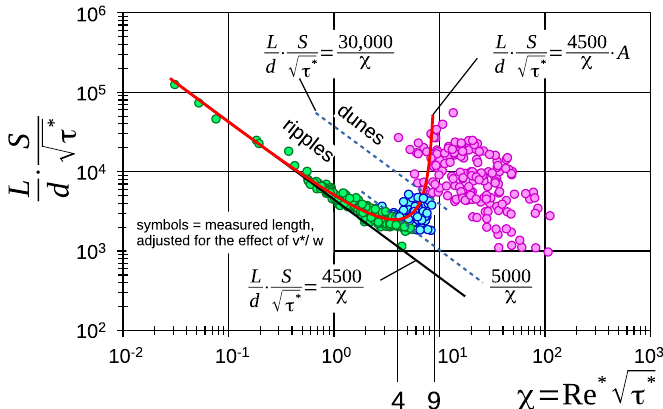
Figure 14. Relative length of ripples and dunes, L / d , as well as their subdivision according to boundary layer instabilities. The data are adjusted for the suspension effect . The ripples, dominated by the acceleration effect, are colored in blue. Red curve: Equation (35), Black line: Equation (35) with A = 1. For data source, see Section